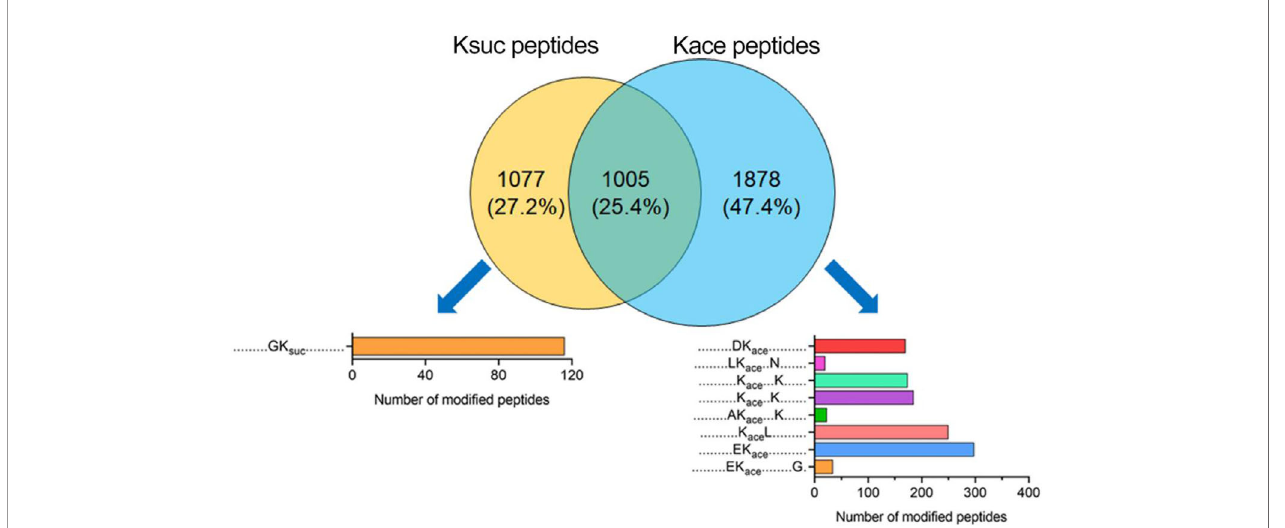
FIGURE 7 | Comparison of succinylation and acetylation peptides in V. alginolyticus Overlap between succinylated and acetylated peptides in V. alginolyticus , and motif